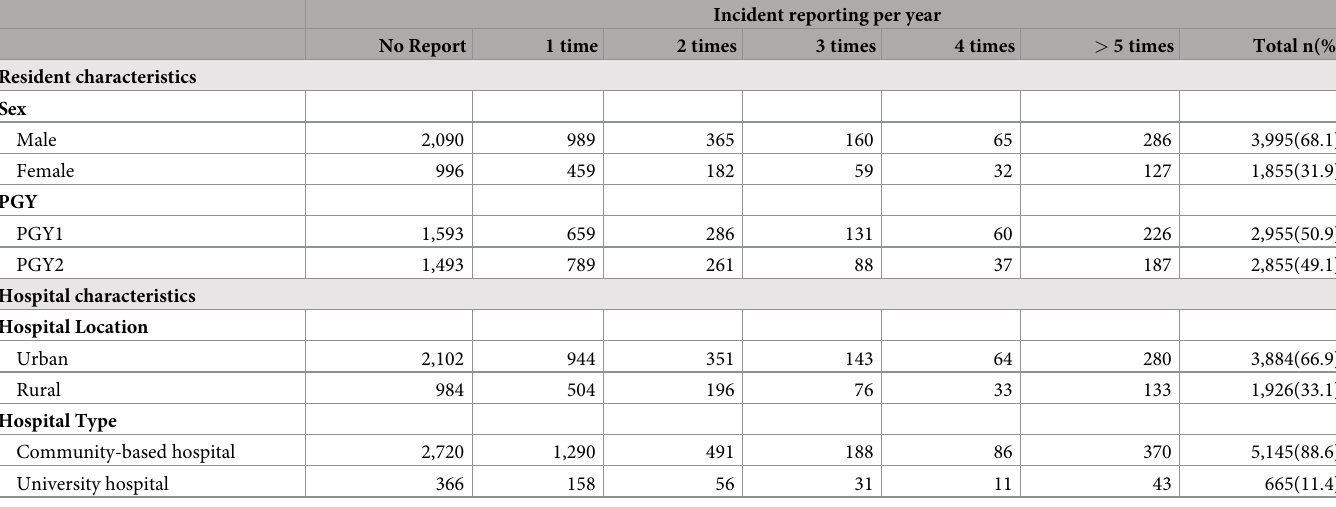
Table 1. Respondent characteristics by experience of incident reporting.